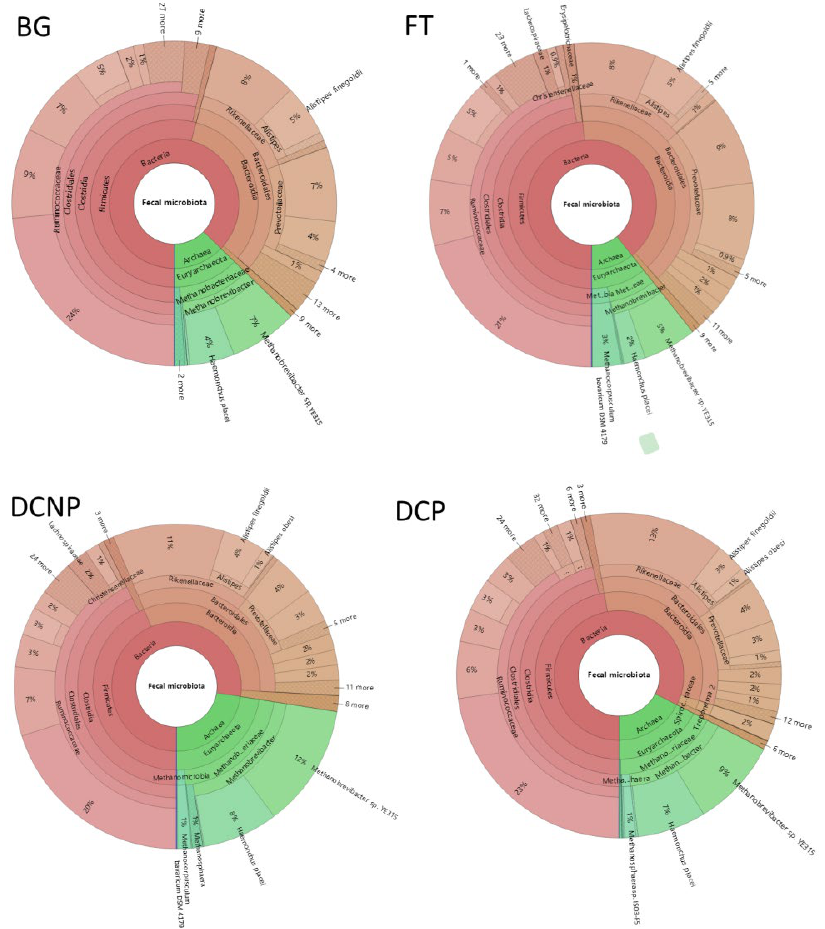
Figure 2. The fecal microbiota composition of the four groups.